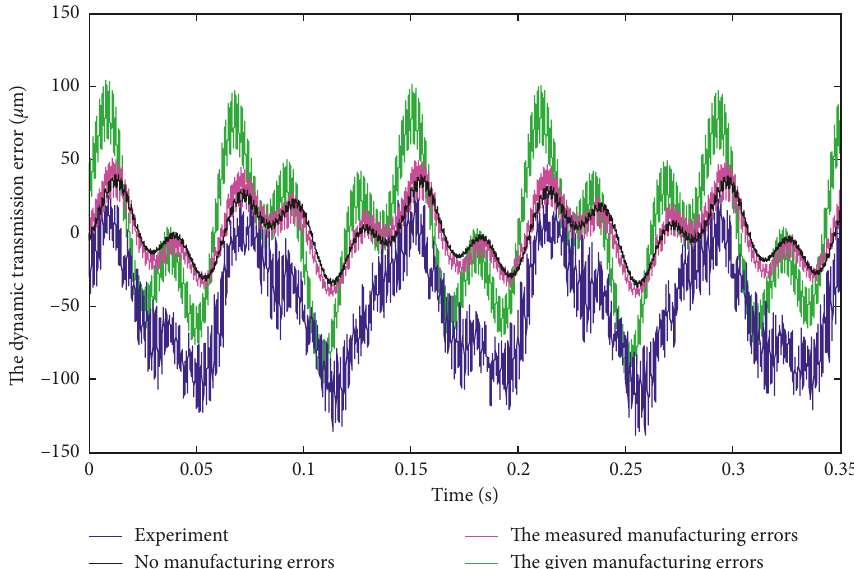
Figure 22: Dynamic transmission error.